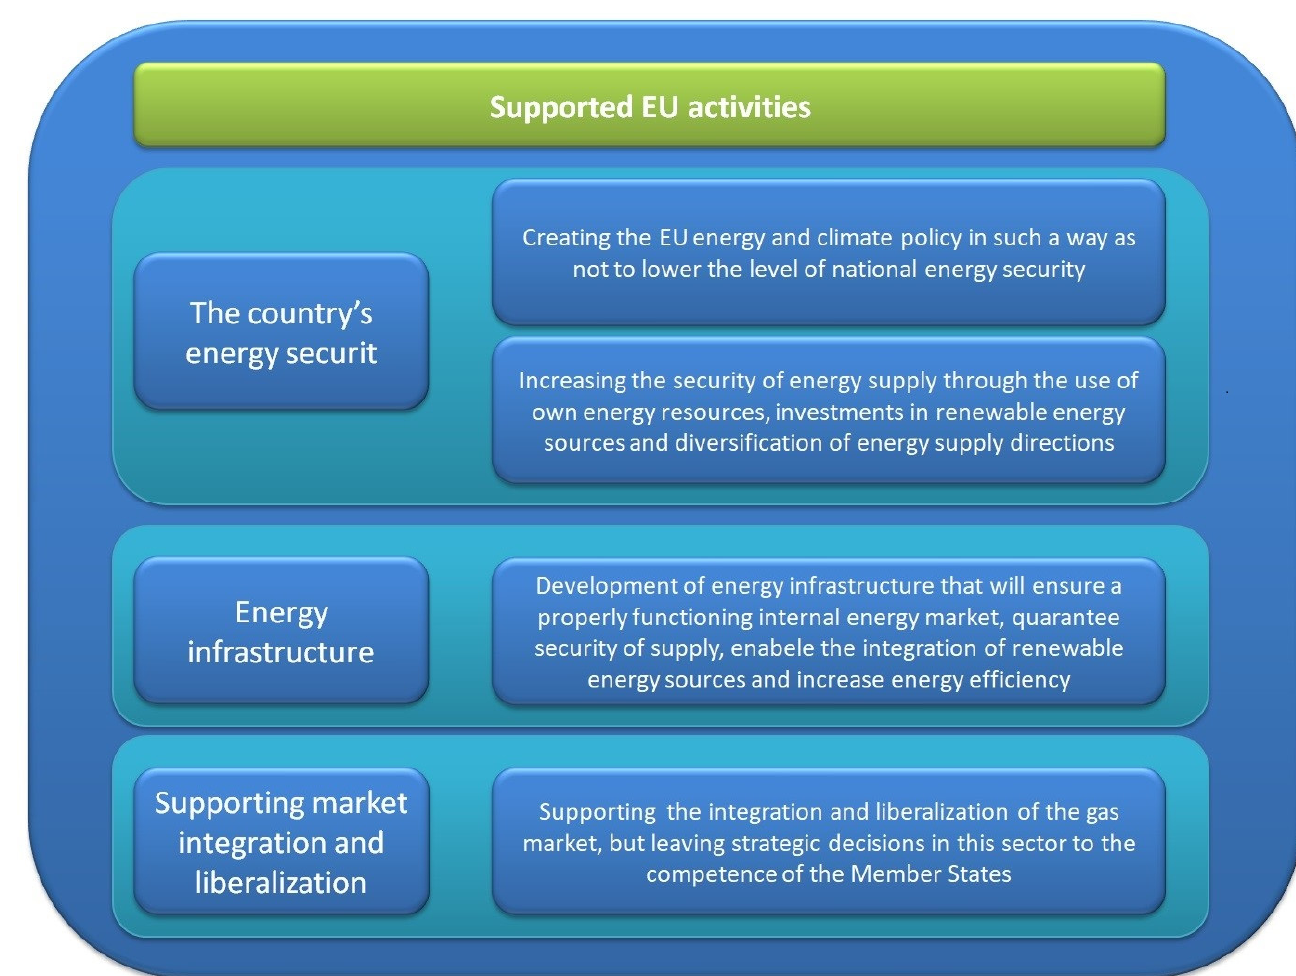
Figure 4. Supported EU activities [29–31].